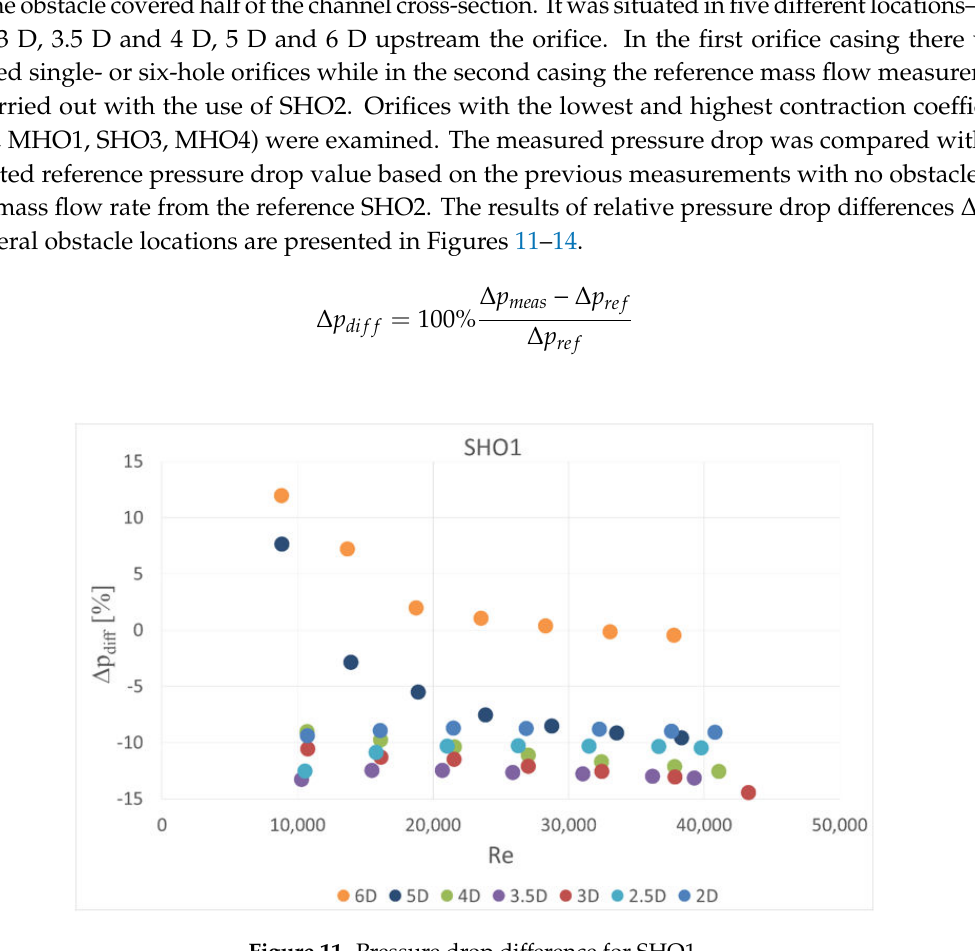
Figure 11. Pressure drop di ff erence for